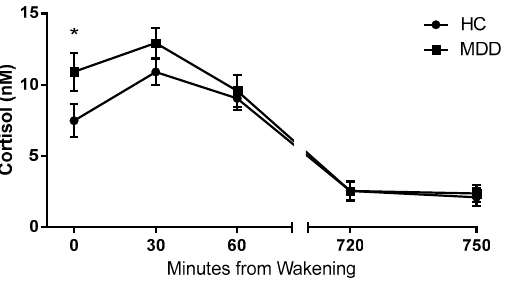
Figure 1. Salivary cortisol concentration data. Salivary cortisol concentrations at five time points from wakening in depressed patients (MDD) ( n = 57) compared with healthy controls (HC) ( n = 41). Depressed patients exhibited a statistically significantly higher cortisol concentration at 0 min from wakening. Data are expressed as means and SEM. * p < 0.05 vs. control. (Mann Whitney-U test on log transformed data).